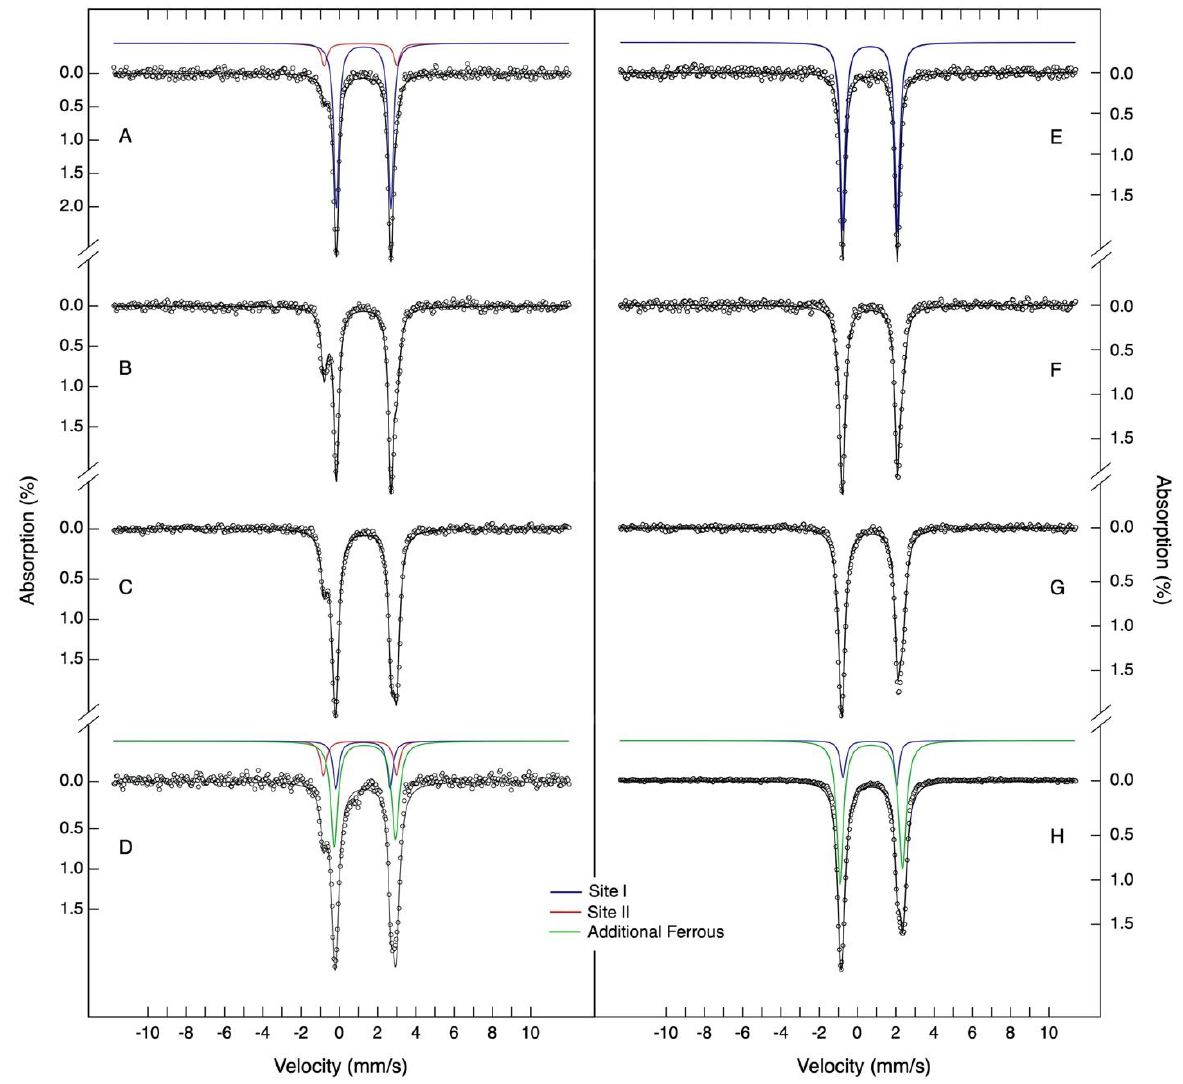
Figure 5. Mössbauer spectra of ferrous iron loading experiments for DgrDps WT and ∆N. Samples of proteins apo-form were incubated with different molar ratios of ferrous 57 Fe (from 6 to 48 Fe per protein, WT in spectra ( A – D ) and ∆N in spectra ( E – H ) in anaerobic conditions for 20 min. Samples were prepared in buffers containing 200 mM MOPS pH 7.0 and 200 mM NaCl. The spectra were recorded at 80 K, with no external magnetic field applied. The solid lines are theoretical simulations using the parameters listed in Table 3. Site I, II, and additional ferrous species are presented in blue, red, and green, respectively. Table 3. Mössbauer parameters of high-spin ferrous species detected in loading experiments using DgrDps WT and ∆N. Contribution of each species in each spectrum after deconvolution is given in percentage and occupancy values. Values in brackets are uncertainties of the last significant digits.